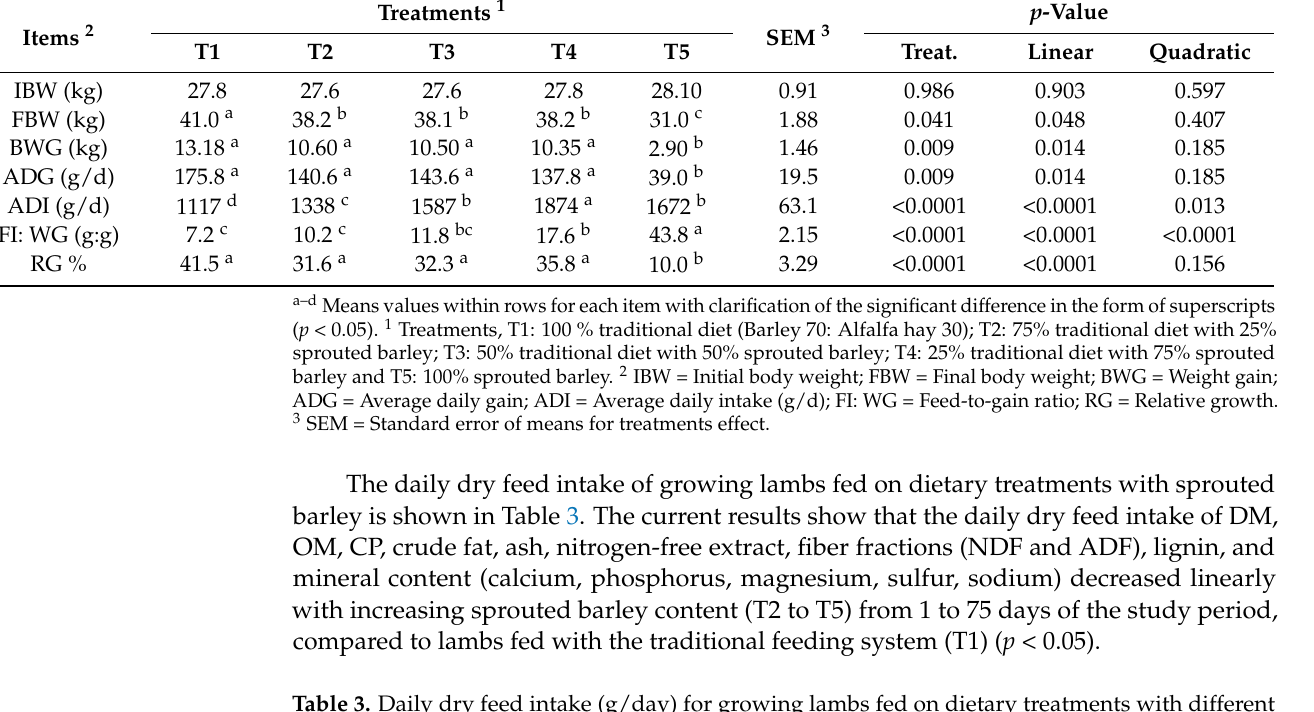
Table 3. Daily dry feed intake (g/day) for growing lambs fed on dietary treatments with different levels of sprouted barley from 1 to 75